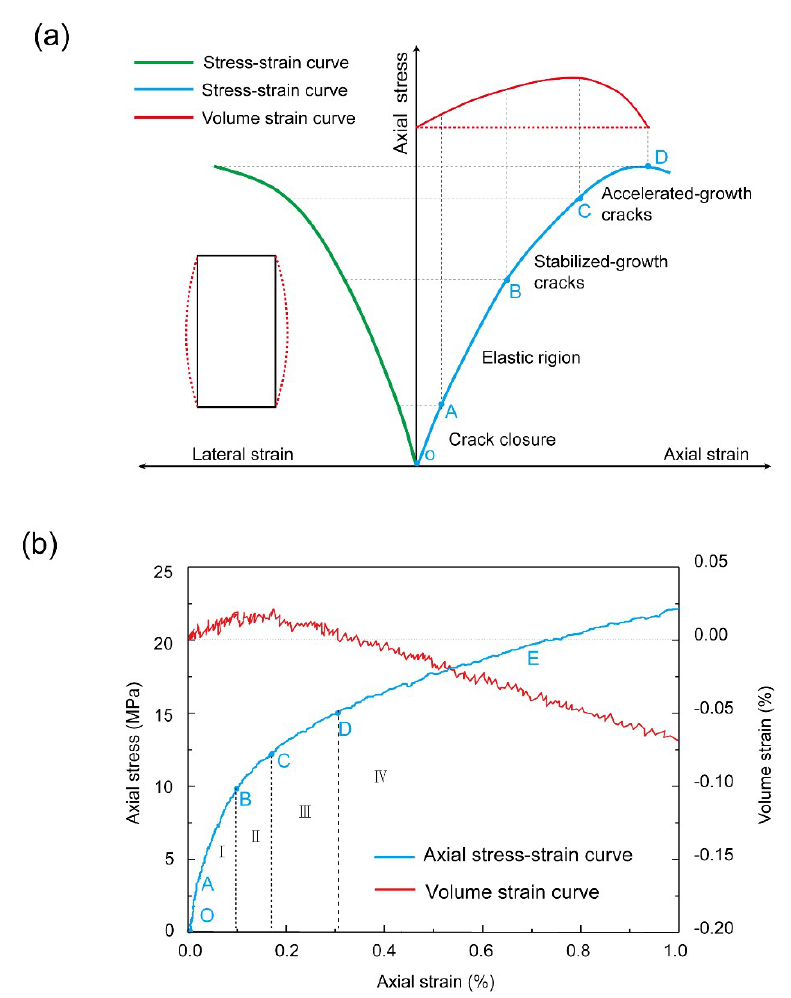
Figure 2. Deformation characteristics of rock under a triaxial loading test: ( a ) stress–strain curve for typical hard rock; and, ( b ) four deformation stages of rock salt under the confining pressure of 5 MPa.